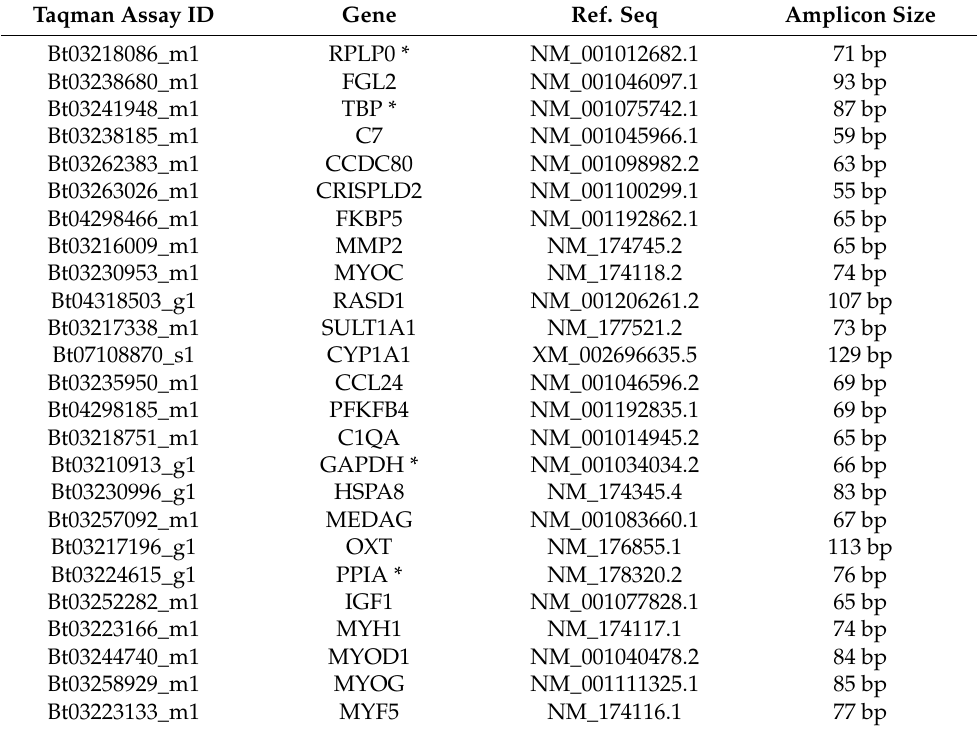
Table 1. List of selected targets for Gene expression study, reference sequences, amplicon sizes and supplier references for each Taqman assay. Reference gene for data normalisation marked with *.